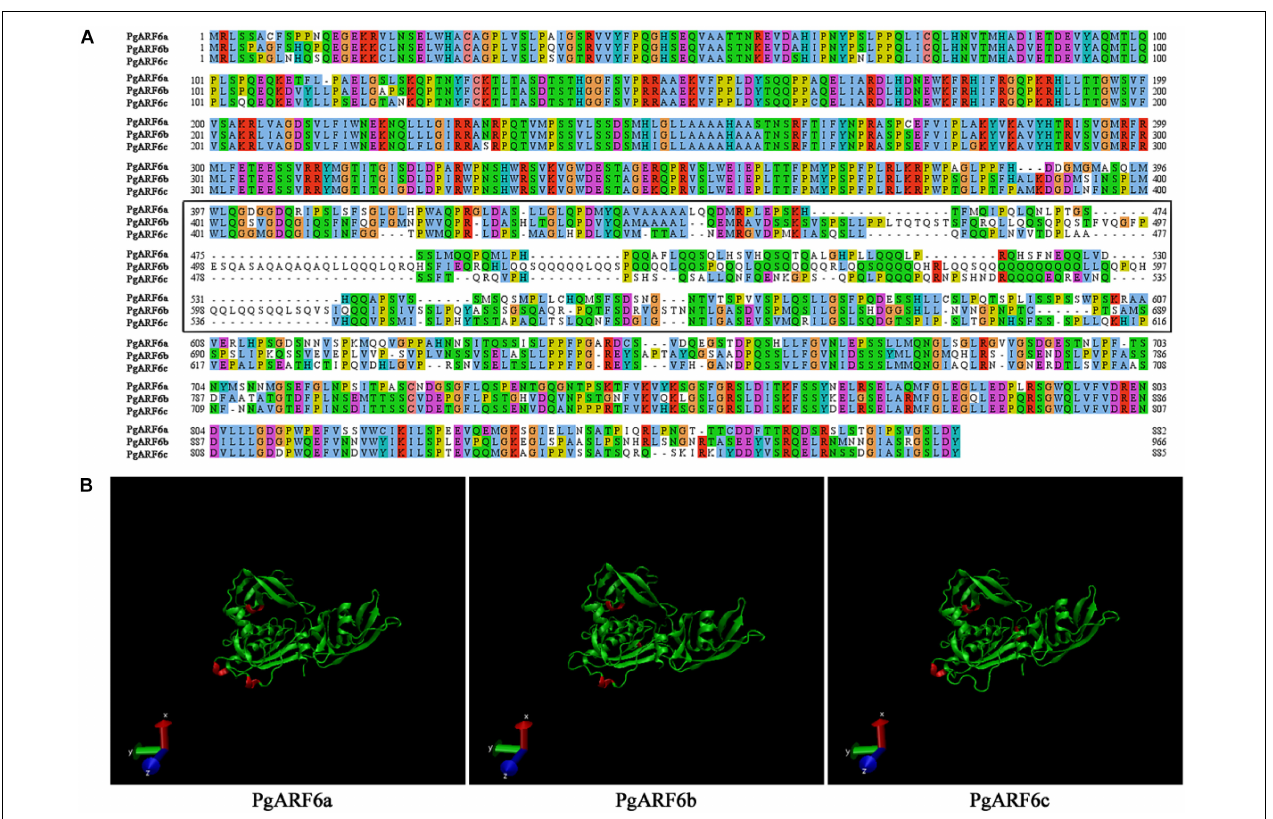
FIGURE 3 | (A) Sequences alignment of PgARF6s. (B) The tertiary structure of PgARF6s.